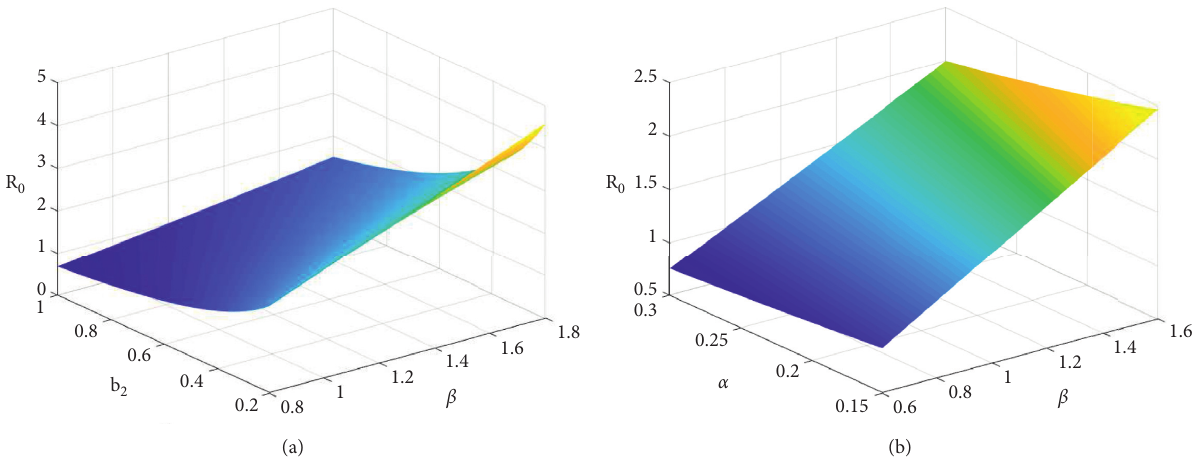
Figure 6: The relationship between parameters and R